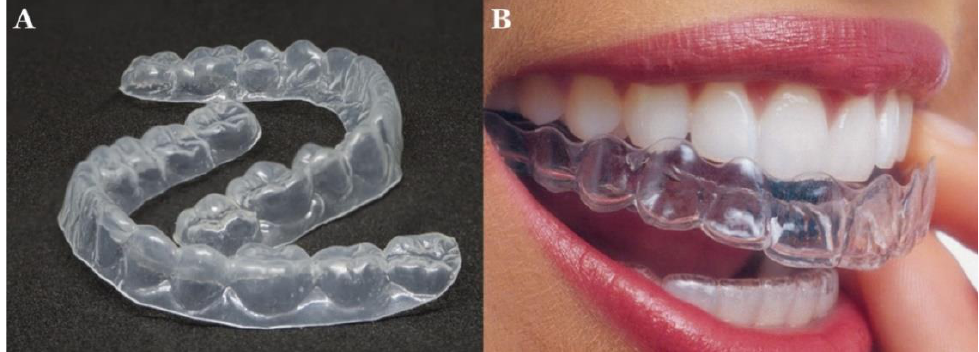
Figure 8. Aligner in the alignment of teeth. Aligners ( A ) and in mouth ( B ).